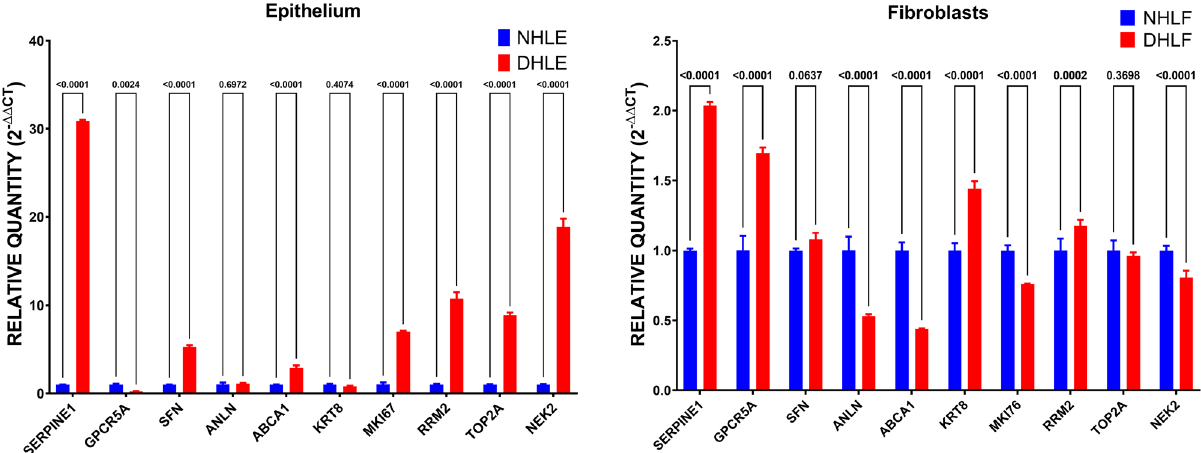
Figure 2. mRNA expression of cell cycle-related genes in healthy bronchial epithelium (NHLE, n = 3) versus asthmatic cells (DHLE, n = 3), and healthy lung fibroblasts (NHLF, n = 3) compared to asthmatic lung fibroblasts (DHLF, n =